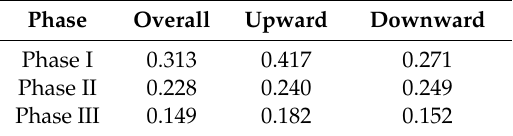
Figure 6. Time-varying dynamics of Hurst exponent H ( q = 2 ) in the case of n = 5. ( a ) Of Phase I; ( b ) Of Phase II; ( c ) Of Phase III. Table 5. Measurement of market e ffi ciency using MDM with H ( − 10) and H